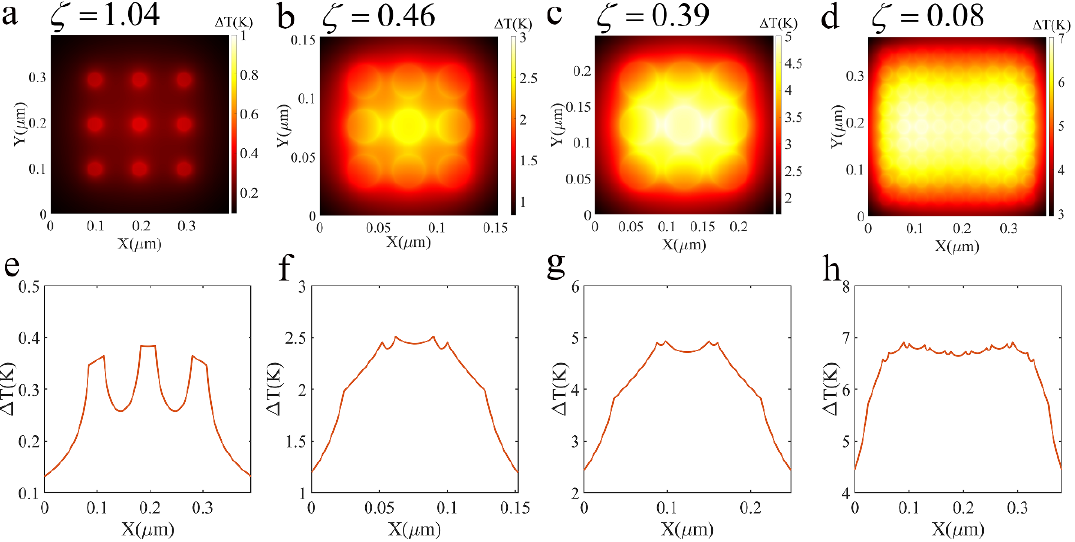
Figure 11. Photo ‐ induced heating of Ag nanoparticle array illuminated by uniform 532nm light with light irradiance I = 1.27 × 10 8 W / m 2 : ( a ) 3 × 3 array ( R = 14 nm , d = 70 nm , Q abs = 0.2635 ), ( b ) 3 × 3 array ( R = 14 nm , d = 10 nm , Q abs = 0.5601 ), ( c ) 3 × 3 array ( R = 26 nm , d = 10 nm , Q abs = 1.0154 ), ( d ) 9 × 9 array ( R = 14 nm , d = 10 nm , Q abs = 0.5601 ), ( e – h ) Temperature variation curve of horizontal center line.